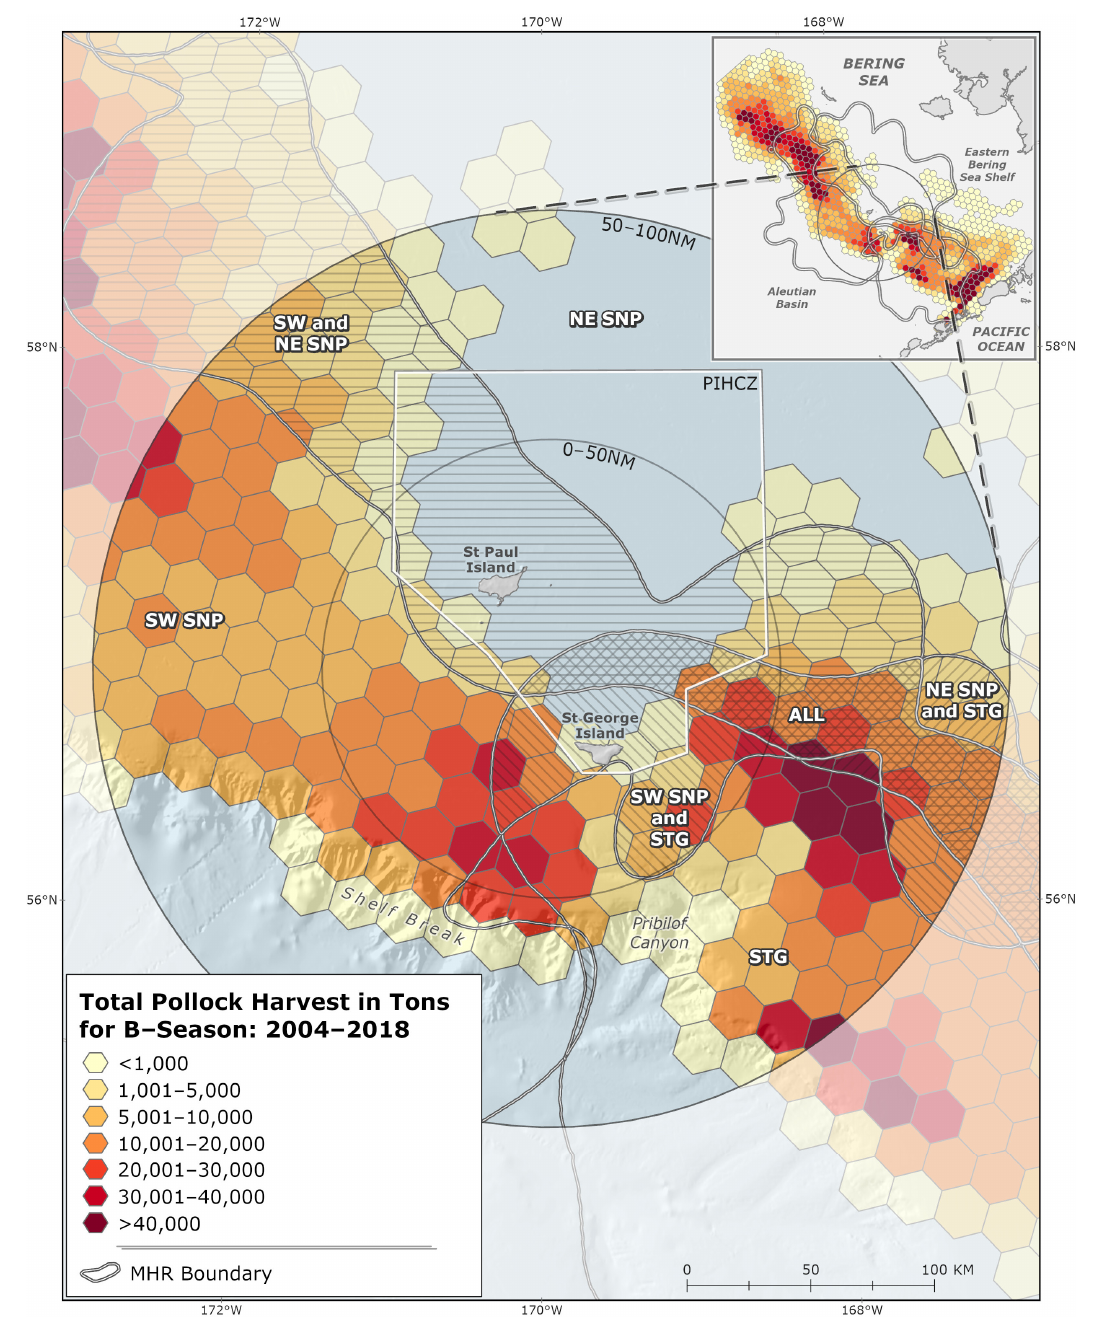
Figure 4. 2004–2018 B-season pollock harvest (t) showing meta-home ranges (MHRs) for lactating female northern fur seals (NFS) overlaid, and showing pollock harvest (t) for the entire eastern Bering Sea (inset). SW SNP = MHR representing southwest St. Paul rookeries, NE SNP = MHR representing northeast St. Paul rookeries; STG = MHR representing St. George rookeries; All = MHR representing overlapping use area from all rookeries. Gray circles are labeled at the 50 nm and 100 nm zones around the Pribilof Islands, and the Pribilof Islands Habitat Conservation Zone (PIHCZ) is pictured.